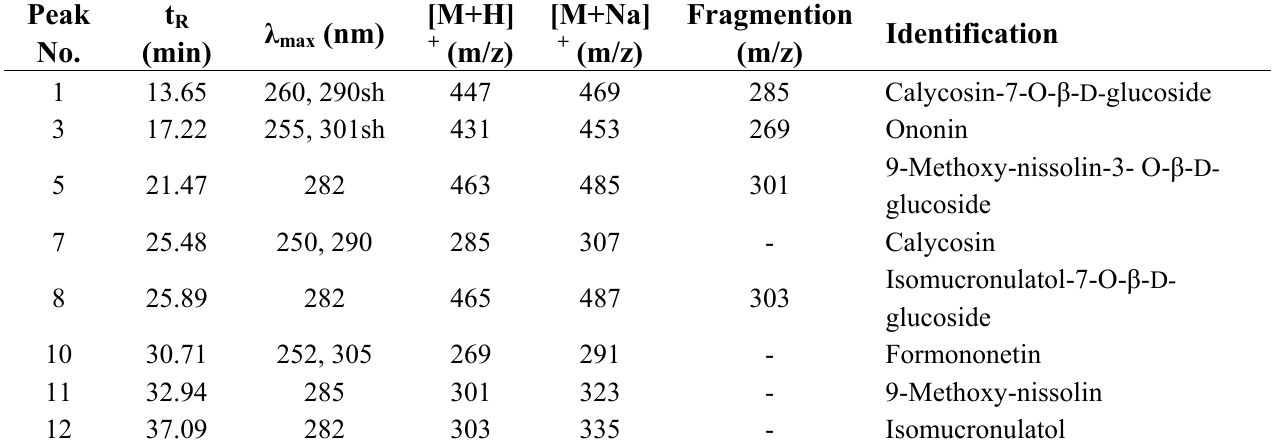
Table 2. Peak assignment of A. mongholicus